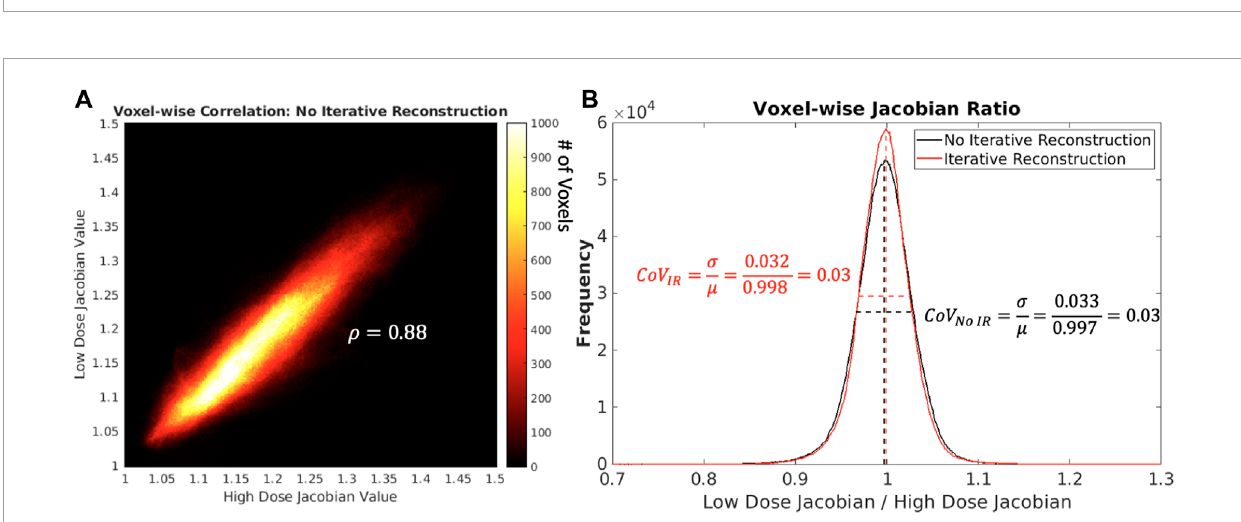
FIGURE 8 In panel (A) on the left shows, a heat map comparing low and high dose 4DCT Jacobian values for one subject on one scan date is shown. The colorbar indicates the number of voxels in each Jacobian value bin. In panel (B) on the right shows, voxel-wise Jacobian ratios with and without IR are shown. Mean and full width half maximum values are shown as dotted lines to highlight how CoV JR was